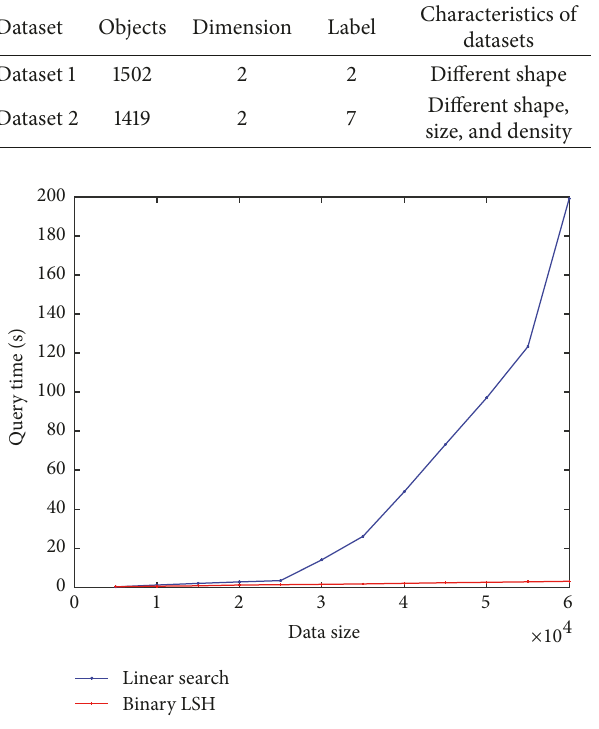
Table 2: Overview of the synthetic datasets used in experiments.